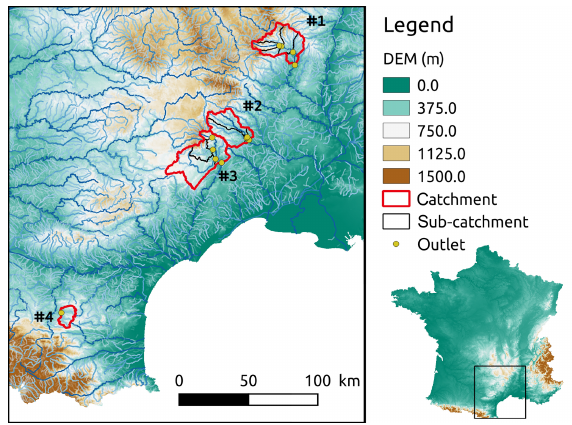
Figure 1. Locations of the catchments studied, with a topo- graphic visualisation at a resolution of 25m (Source – IGN; MNT